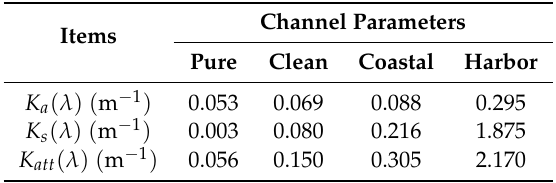
Table 2. Underwater optical channel parameters based on